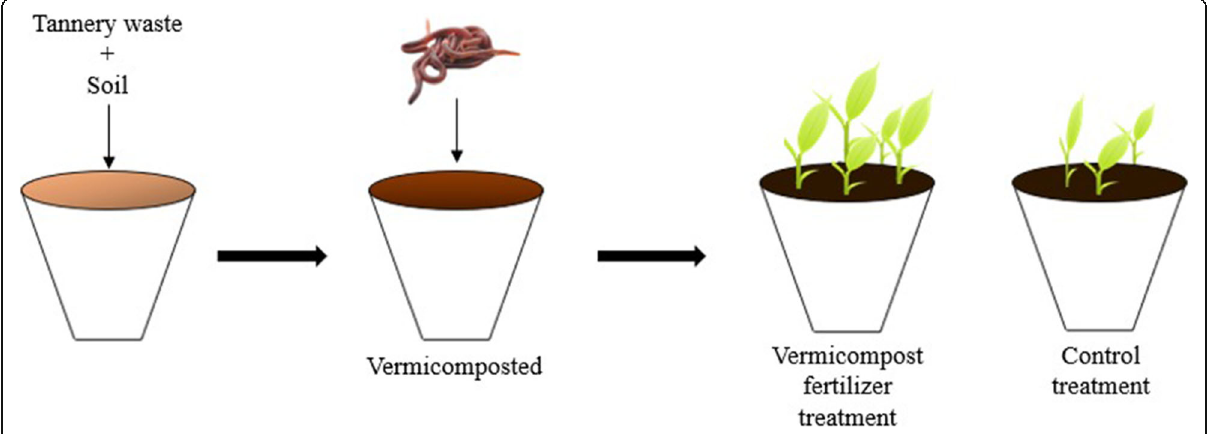
Fig. 6 Stages of vermicompost production from tannery